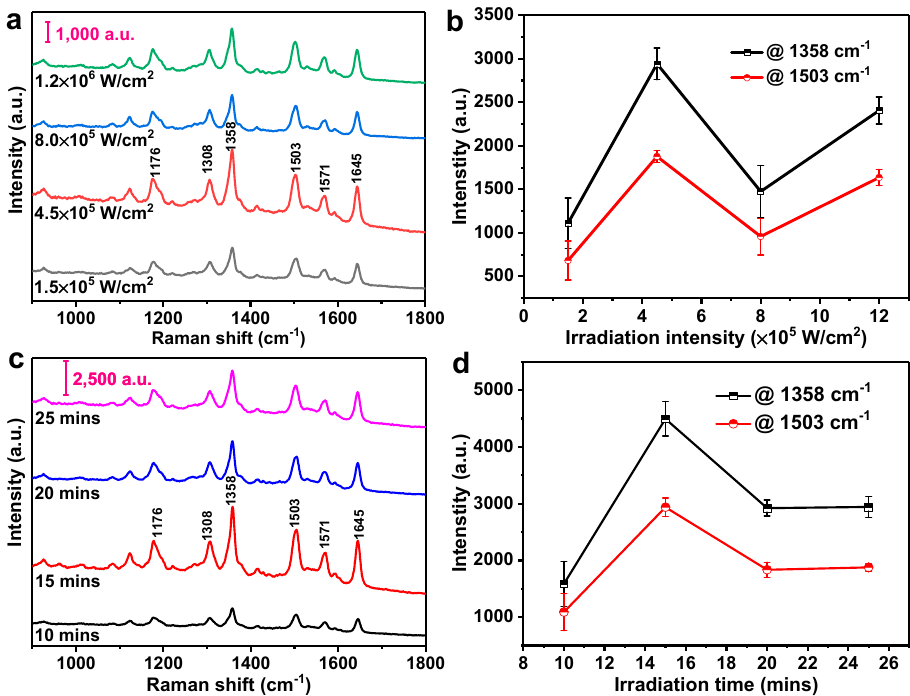
Figure 5. ( a ) SERS spectra of 10 − 6 M R6G adsorbed on the silver nanoaggregates prepared under different irradiation intensities at the fixed irradiation time of 25 min; ( b ) Raman signal intensities of R6G at 1358 cm − 1 and 1503 cm − 1 versus the irradiation intensities. ( c ) SERS spectra of 10 − 6 M R6G adsorbed on the silver nanoaggregates prepared under different irradiation time at the fixed irradiation intensity of 4.5 × 10 5 W/cm 2 ; ( d ) Raman signal intensities of R6G at 1358 cm − 1 and 1503 cm − 1 versus the irradiation time. The power of the excitation laser was 38.2 μ w, and the acquisition time was 10 s for each spectrum.